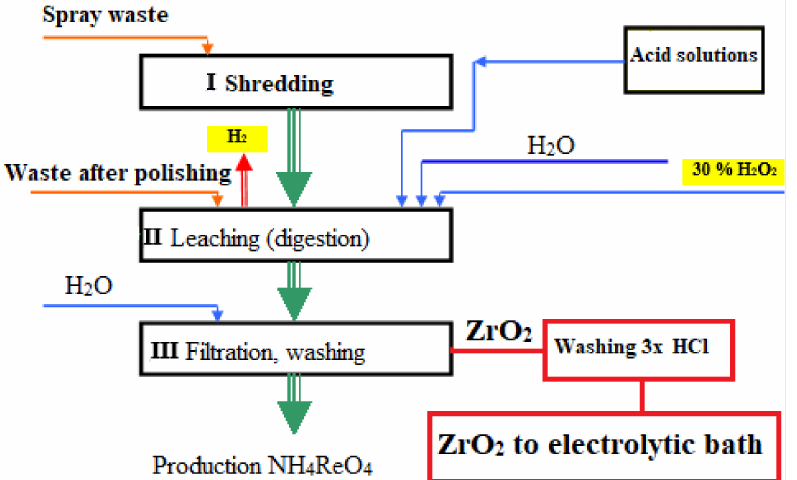
Figure 1. Diagram of zirconium oxide production used in the composite electro-fabrication